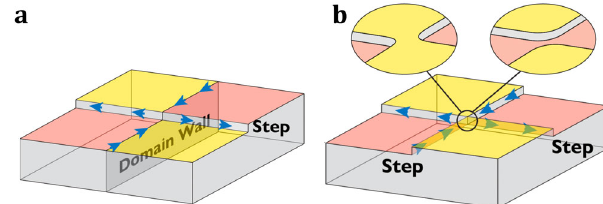
Fig. 2 Stable and unstable junctions. a The intersection of a domain-wall channel with a step channel results in a thermodynamically stable junction, i.e., small surface deformations can only move the junction but not remove it. b The intersection of two step channels (or two domain-wall channels) is unstable. The inset shows how small deformations remove the junction. Blue arrows indicate the direction of propagation on the chiral channels, while orange and yellow surfaces indicate whether the anomalous Hall conductivity is ± e 2 /2 h Fig. 2a (see also Supplementary Movies for time-evolution ani-